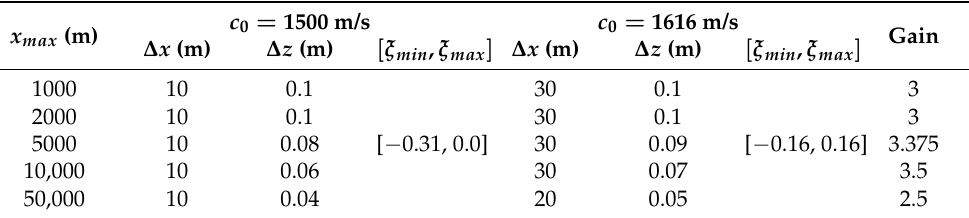
Table 4. Optimal values of the cell sizes. ε = 10 − 3 , θ max = 30 ◦ , f = 500 Hz, rational approximation order is [ 7/8 ]